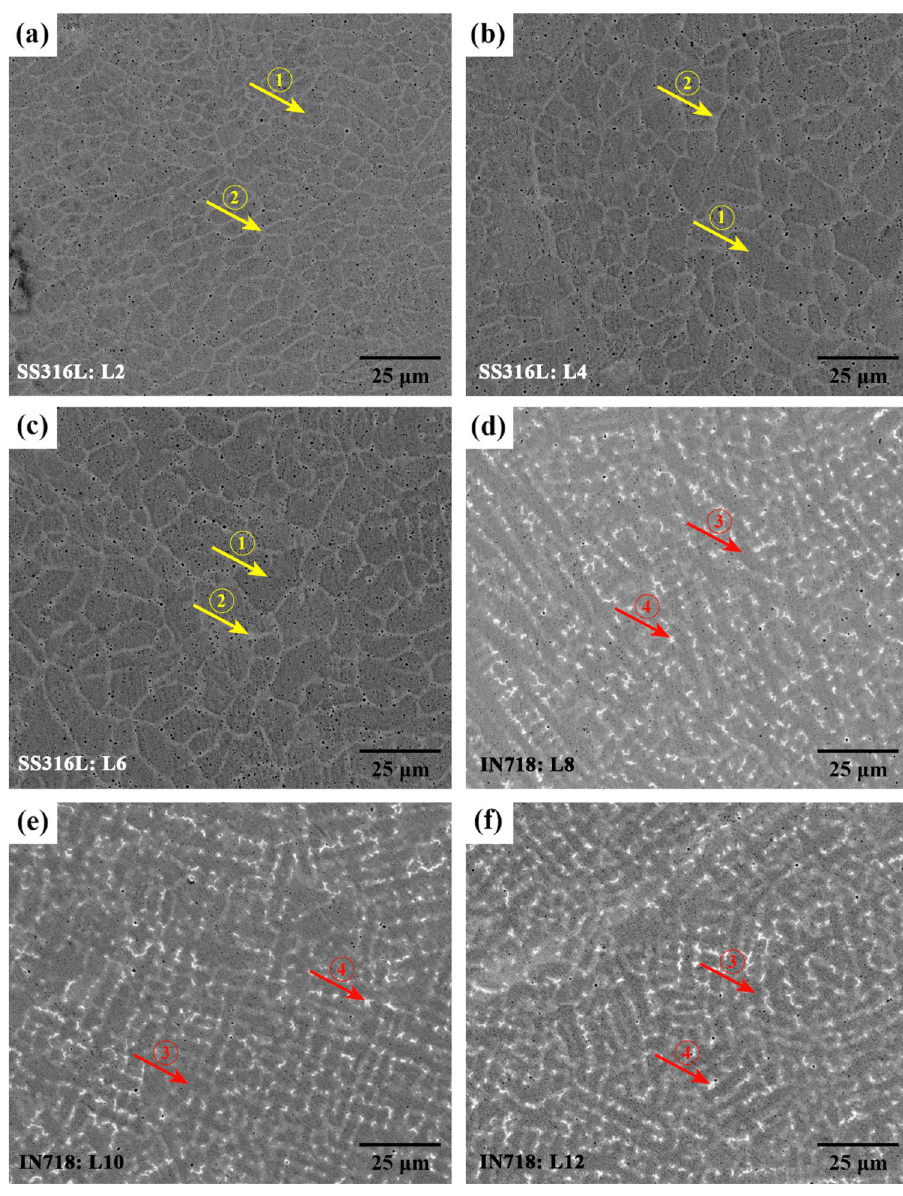
Figure 12. The cross-section microstructure of SS316L layers: ( a ) 2, ( b ) 4, ( c ) 6 and IN718 layers: ( d ) 8, ( e ) 10, and ( f ) 12. The numbered arrows show the different contrasts selected for EDS analysis and the possible